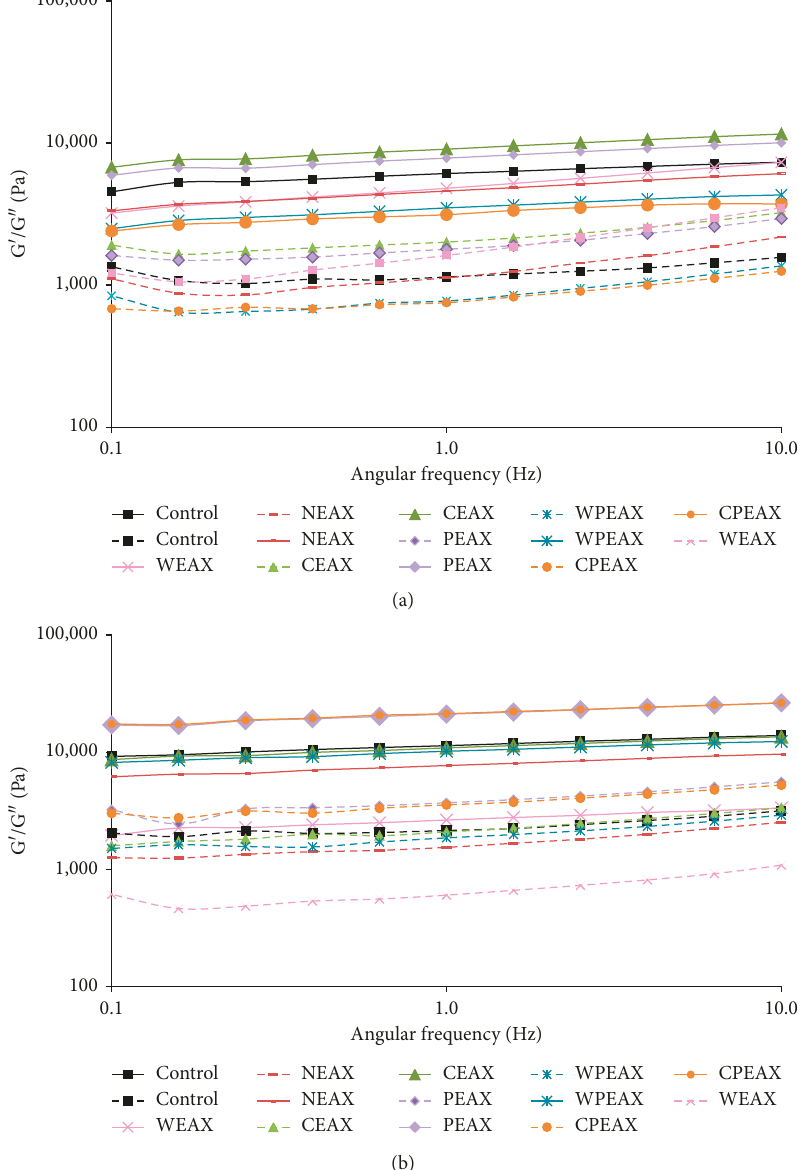
Figure 2: Mechanical spectra of GF model systems added with differently extracted AXs at 25 ° C and 0.01% strain after 30min resting. (a) Buckwheat model systems. (b) Millet model systems. Continuous line: